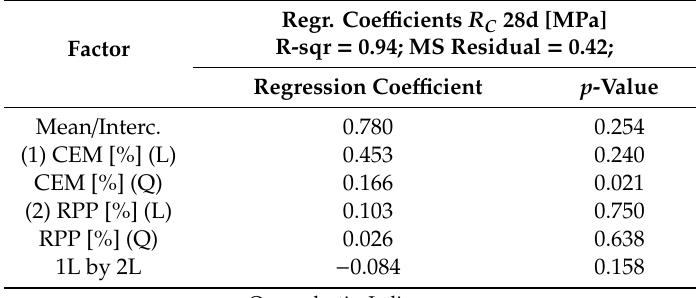
Table 10. Experimental coe ffi cients for axial compressive strength R